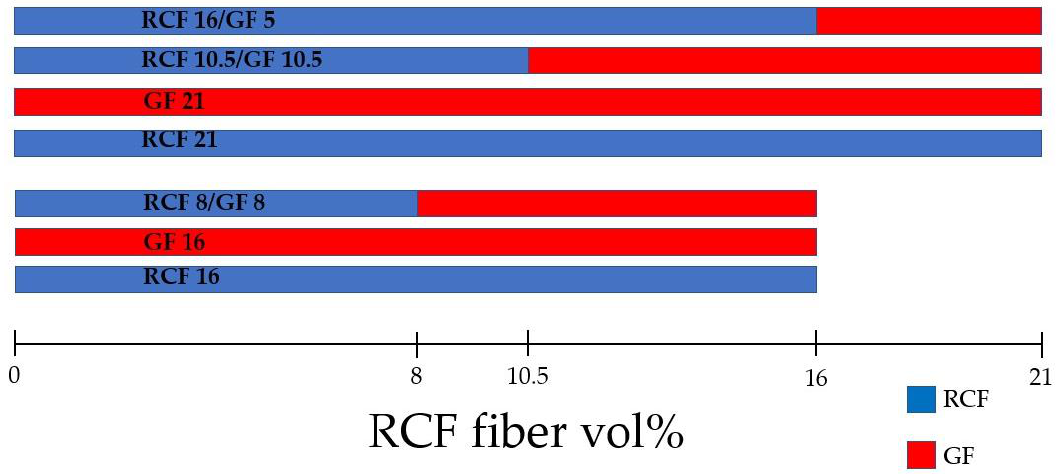
Figure 1. Fiber volume ratios and reference compounds with GF (red) and RCF (blue).